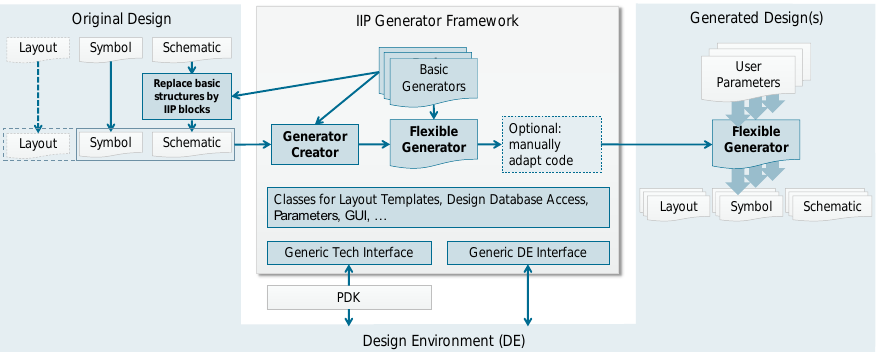
Figure 6. Flow chart of the Generator Creator flow. Given a design as the input, the Generator Creator analyzes and abstracts the given information through the Generator Framework. In this step, also the PDK-related information is mapped to a generic representation. With the generator code automatically created, the user can immediately run the generator. The generation procedure also includes the layout view which is parameterized through the template system.